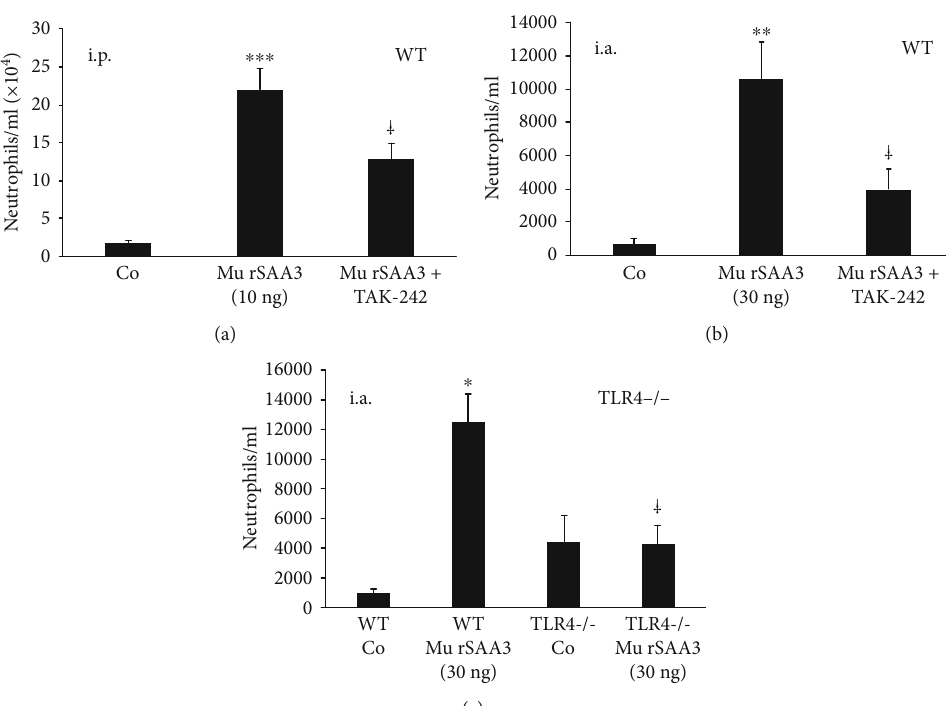
Figure 5: In vivo recruitment of neutrophils towards impure mu rSAA3 is mediated by activation of TLR4. (a) Female NMRI mice were injected i.p. with PBS (Co), mu rSAA3 (10 ng) or with a combination of mu rSAA3 (10 ng) and the TLR4 inhibitor TAK-242 (75 μ g; 9-12 mice per group). After 2h, mice were sacri fi ced and peritoneal lavages were performed. (b) Male C57BL/6J mice were injected i.a. in the knee with 0.9% NaCl (Co), mu rSAA3 (30 ng), or with a combination of mu rSAA3 (30 ng) and TAK-242 (75 μ g; 7-10 mice per group). After 3 h, mice were sacri fi ced and articular lavages were performed. (c) Male C57BL/6J wildtype (WT) and TLR4 knockout (TLR4 -/- ) mice were injected i.a. in the knee with 0.9% NaCl (Co) or mu rSAA3 (30 ng; 3-5 mice per group). After 3 h, mice were sacri fi ced and articular lavages were performed. (a – c) Lavages were subjected to total cell count and cytospins were prepared for di ff erential leukocyte counts by 2 individuals independently. Data represent the total number of neutrophils/mllavage ± SEM and are derived from 1 (c), 2 (b), or 3 (a) experiment(s). Statistically signi fi cant recruitment of neutrophils compared to control mice, determined by the Mann-Whitney U test, is indicated by asterisks ( ∗ p < 0 : 05 ; ∗∗ p < 0 : 01 ; ∗∗∗ p < 0 : 001 ). Statistically signi fi cant inhibition of neutrophil recruitment compared to mice injected with mu rSAA3 alone (a and b) or to wildtype mice injected with mu rSAA3 (c), determined by the Mann-Whitney U test, is indicated by a dagger ( † p < 0 : 05